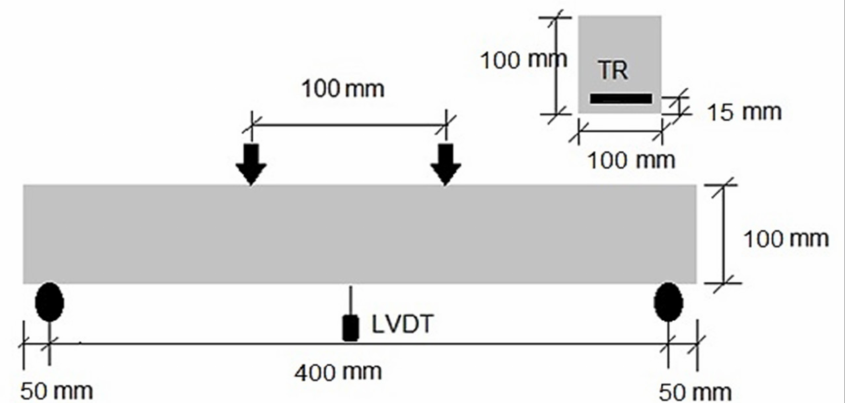
Figure 2. Schematic four-point bending test set-up of small-scale beams. Weaved fabric and two alternative layouts were employed in bi-axial textile